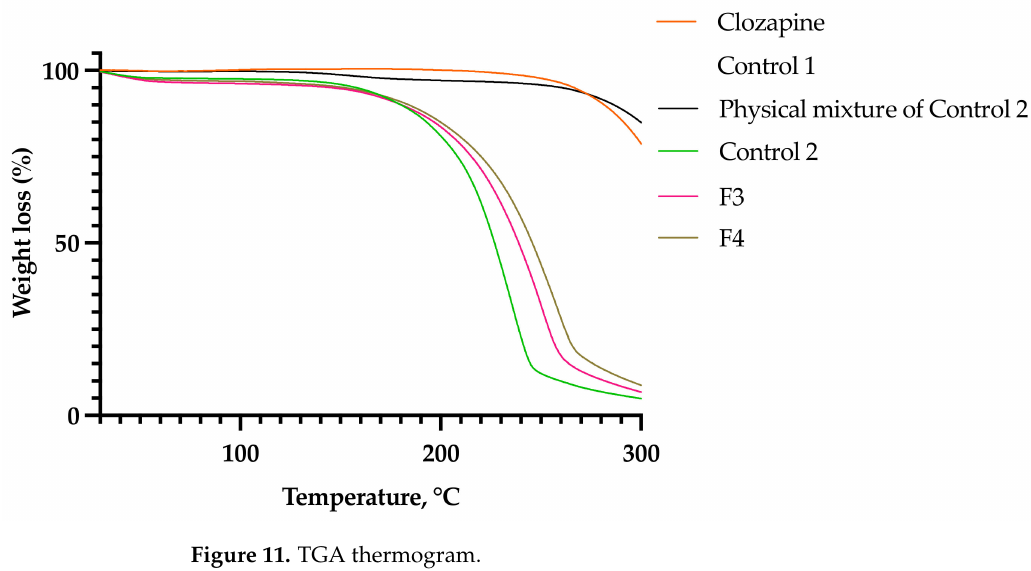
Figure 11. TGA thermogram.